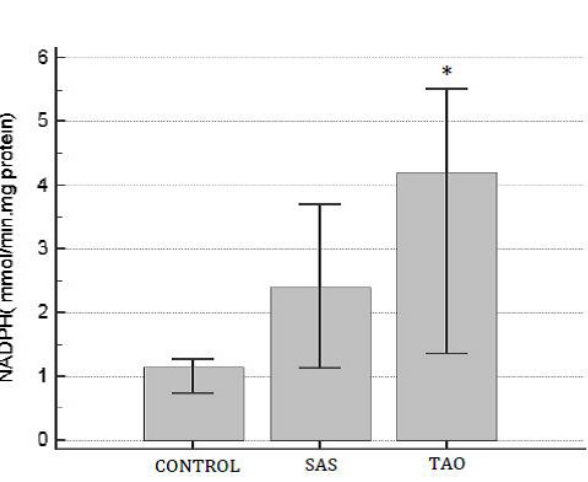
Fig. 2 - NADPH oxidase activity on human aortas of patients with severe aortoiliac occlusive stenosis (SAS) and with total aortoiliac occlusion (TAO). Values are expressed in mean and the brackets represent interval of confidence of 95%. ANOVA followed test t. *P<0.05 when compared to control group..